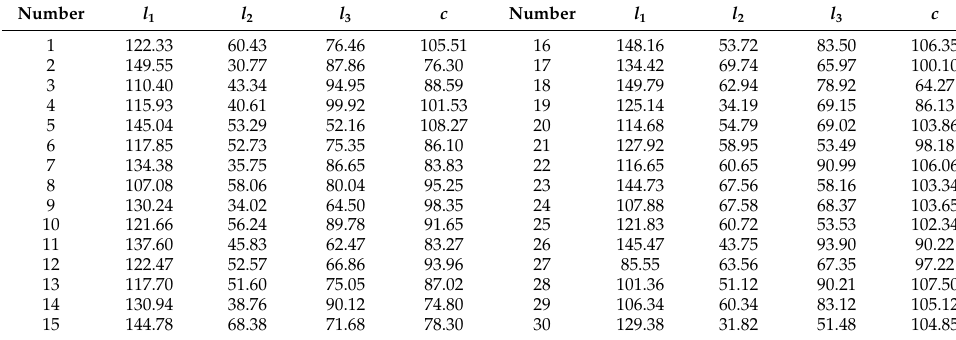
Table 5. Optimized design variables.